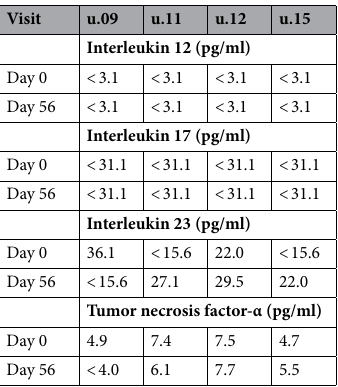
Table 4. Changes in the levels of serum cytokines and comparisons before (day 0) and after (day 56) genistein administration in patients u.09, 12 and 15, and in genistein-untreated placebo